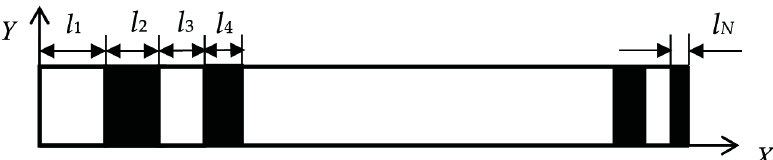
Figure 1. The schematic illustration of APPLN crystal, where white and dark colors are used for regions with opposite sign of nonlinear coefficient d 33 .